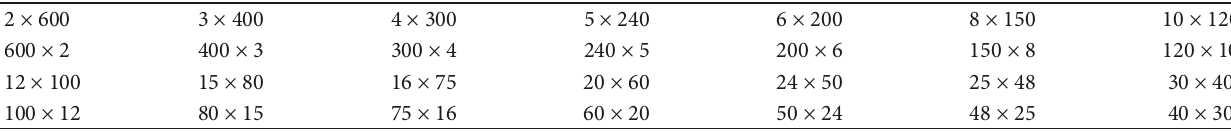
Table 3: Transmitter-receiver combination.